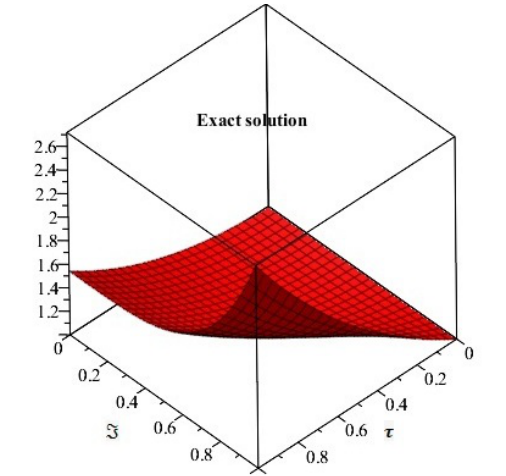
Figure 1. Represents the exact solution of Example 1 at β = 2.